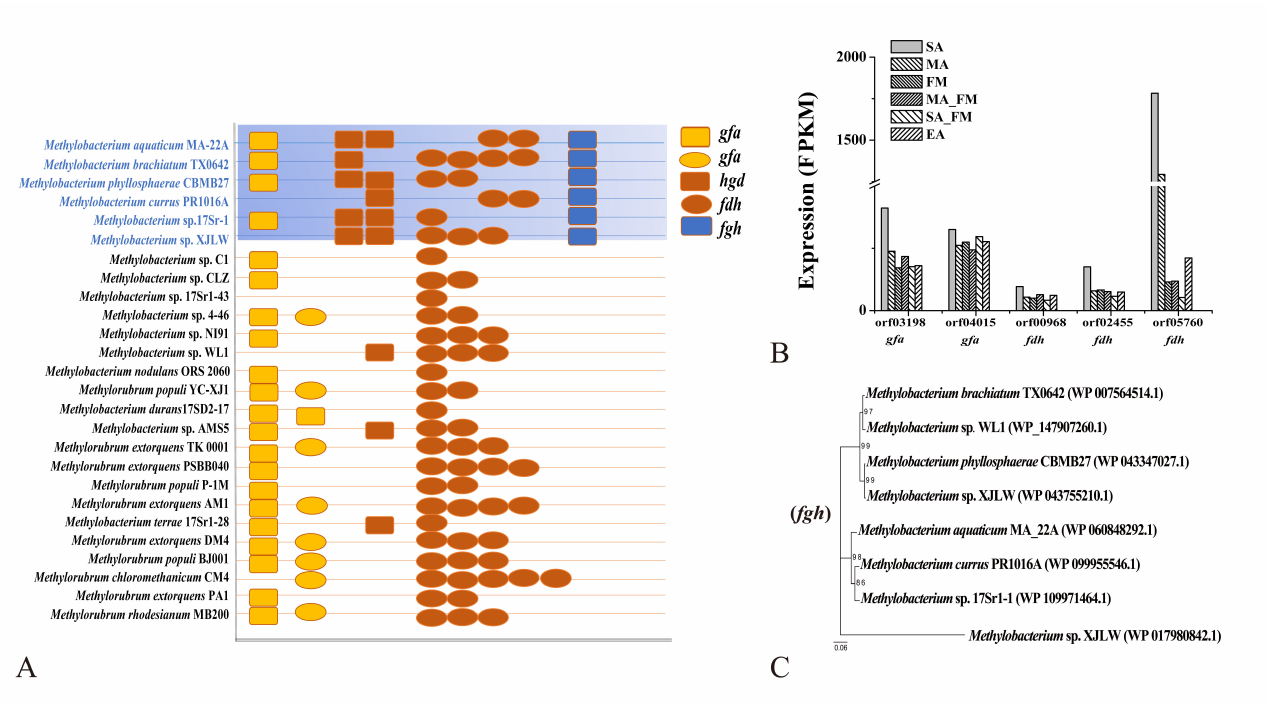
Figure 6. ( A ) The distribution of all genes in GSH on 26 strains and gene copies. The ordinate is the strain name: yellow square represents gfa gene, orange square represents hgd gene, orange circle represents fdh gene, and blue square represents fgh gene. The highlighted part in blue is the strain with complete GSH pathway, and the rest is the strain without fgh gene. ( B ) The FPKM values of genes from GSH pathway in strain MB200 grown under 6 different carbon sources. The abscissa is gene and number. Different blocks represent different carbon sources. ( C ) Phylogenetic tree of fgh gene in strains highlighted in